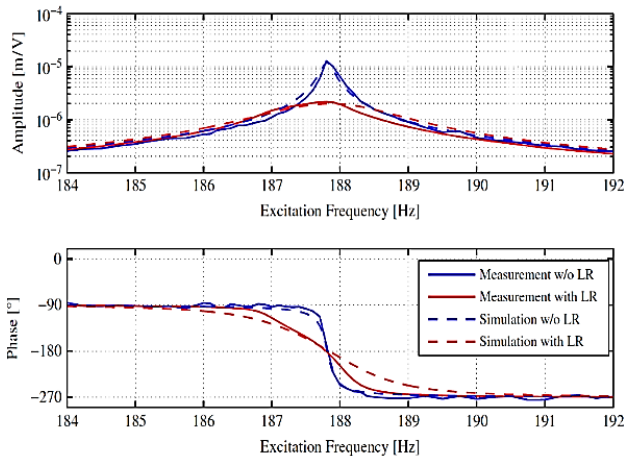
Figure 2. Comparison of amplitude – frequency and phase – frequency with and without LR match-